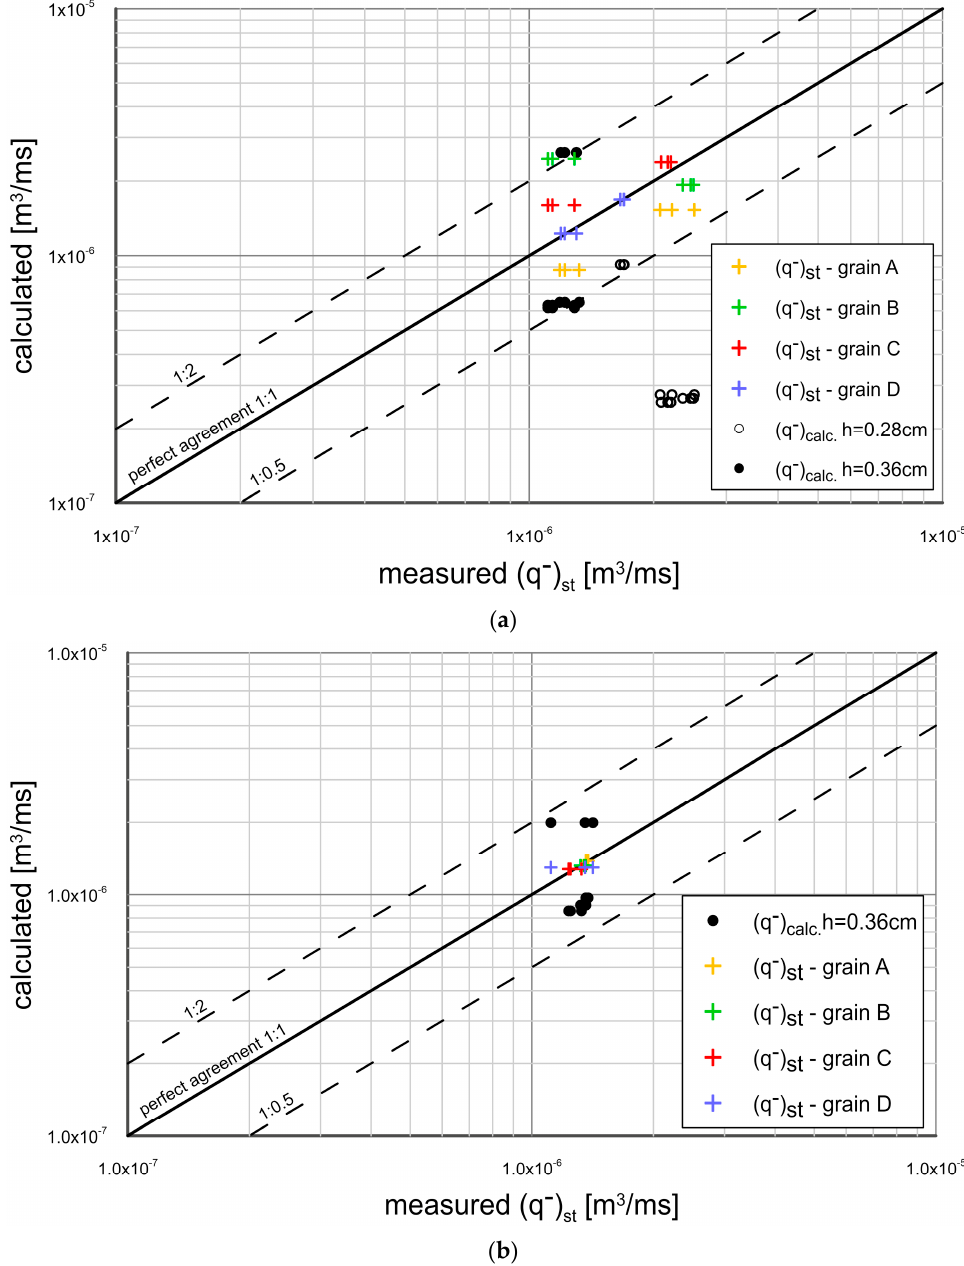
Figure 12. Comparison of calculation and measurements results q − between flat ( a ) and sloped bed ( b ) cases during the trough.